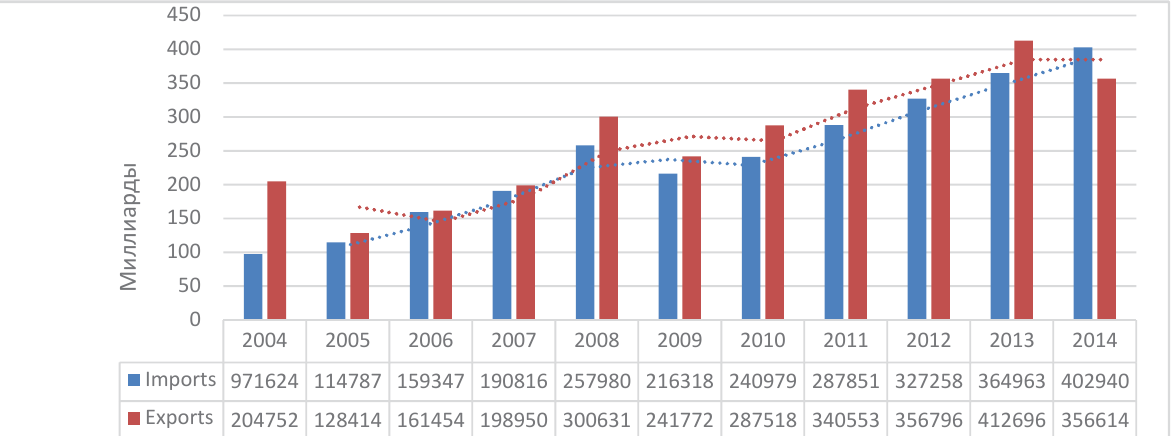
Fig. 12. The COJ import and export trends 2004-2014 current prices Source: adopted from Quantec Database